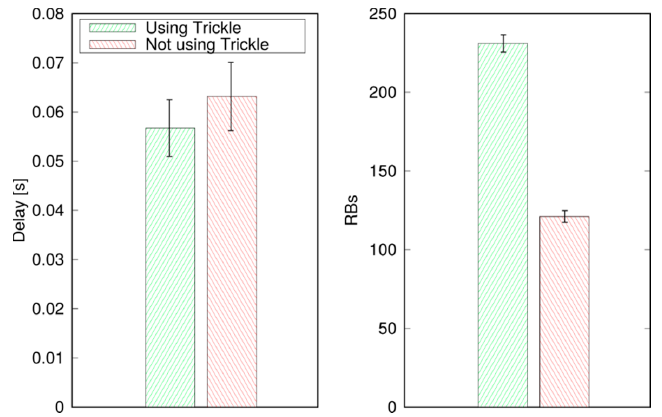
Figure 13. Average delay ( left ) and average allocated RBs ( right ), w and w/o Trickle.